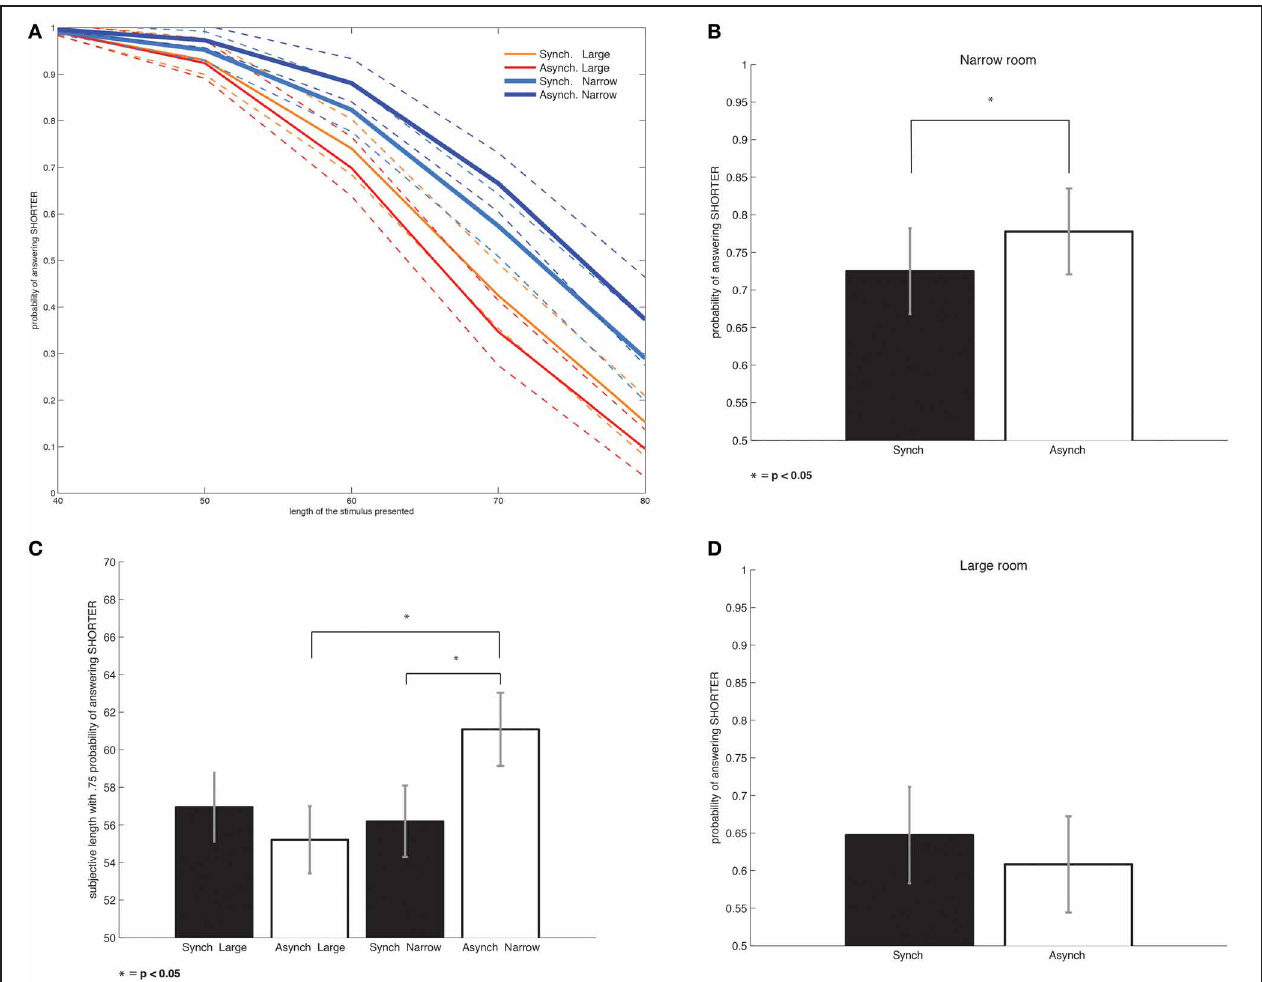
FIGURE 4 | Bodily self-consciousness modulates length estimation. (A) The result of the Probit analysis shown for the four conditions across all bar lengths. The fit of the curves together with the confidence intervals suggest that the modulation in length estimation is specific for the narrow room and modulated by the stroking synchrony factor. (B) The effect of the stroking synchrony factor on the responses, independent of the presented bar length, is shown considering only responses in the narrow room. A Probit analysis shows a significant effect of the stroking synchrony factor, irrespective of the